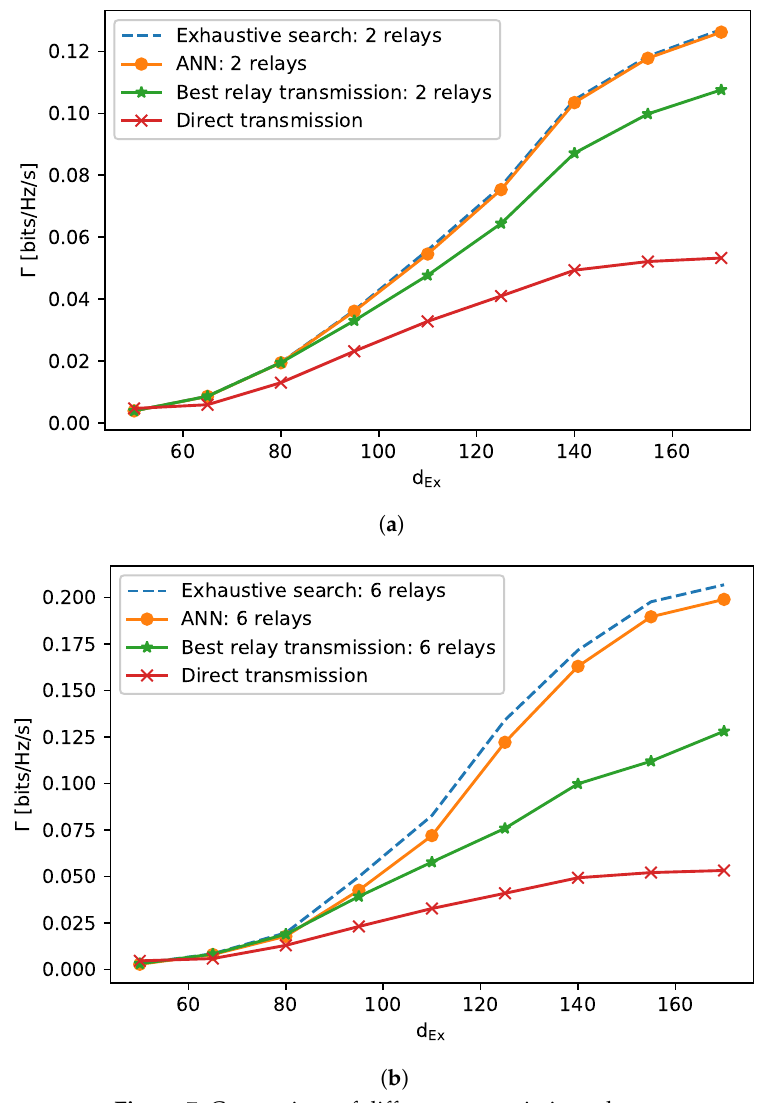
Figure 7. Comparison of different transmission